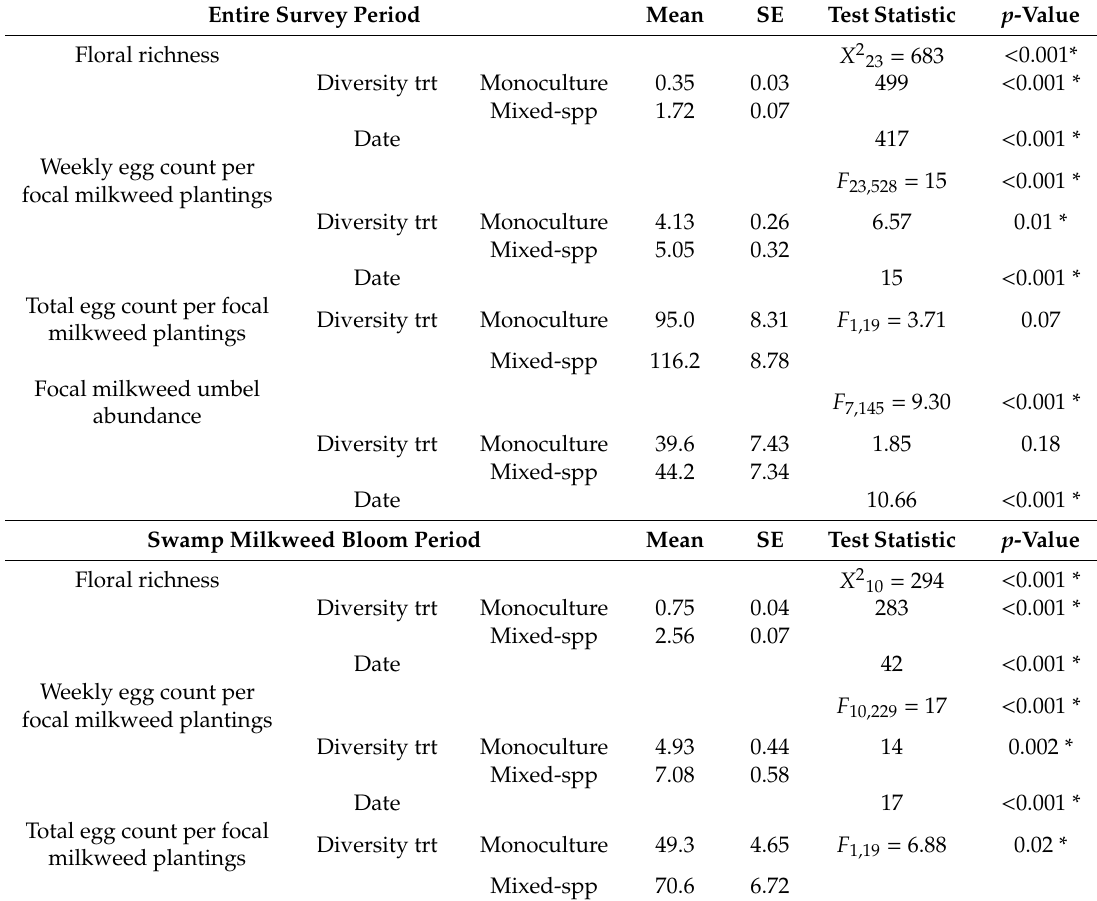
Table 1. Results comparing average floral richness, monarch egg abundance, and swamp milkweed umbel abundance between the monoculture and mixed-species treatments and survey dates. The lower portion on the table compares floral richness and monarch egg abundance between treatments during the period of swamp milkweed bloom